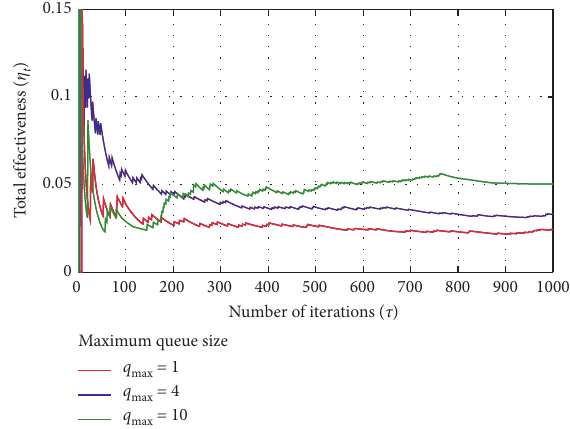
Figure 11: Convergence of the HGMP’s total effectiveness for � 1, q � 4, and q � 10, during τ q max max max